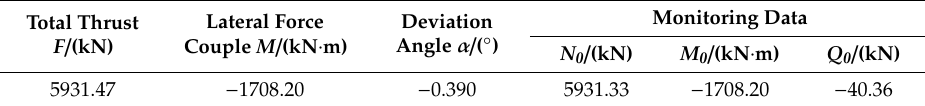
Figure 8. Comparison of horizontal accumulated displacements of the segments. Table 1. Initial parameters for calculation